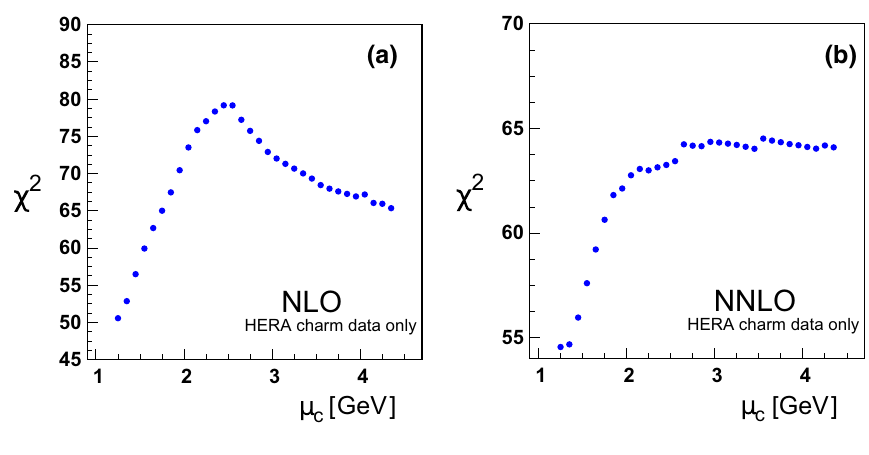
Fig. 6 χ 2 vs. the charm matching scale μ c at a NLO and b NNLO for only the H1-ZEUS combined charm production data; note, this includes the correlated χ 2 contribution from Tables 1 and 2